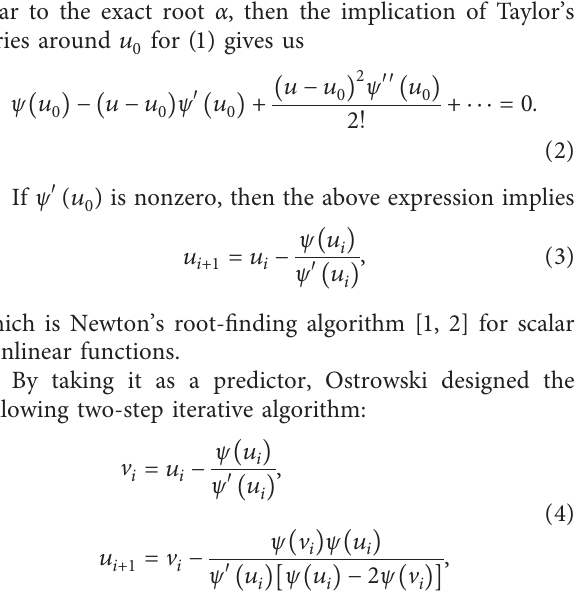
Algorithm 1 is a new iteration scheme for calculating